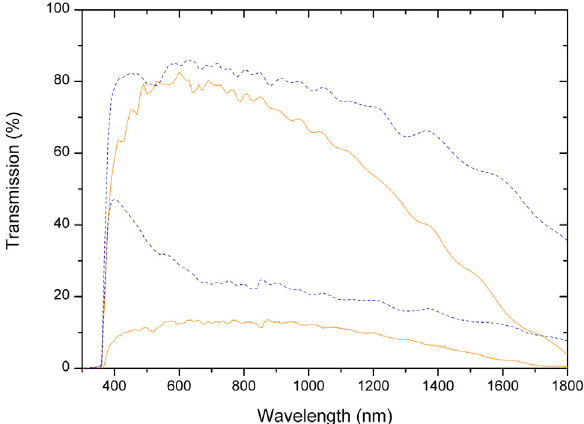
Fig. 3. Total and diffuse transmission of 5 µ m thick nanoporous structure deposited on FTO glass (blue dashed line) and ZnO:Al (red full